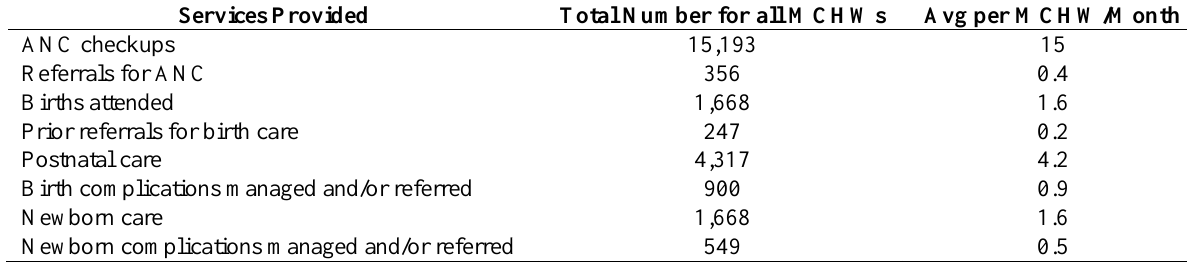
Table I : Services Provided by the 112 MCHWs over the Nine-Month Period of the Study Services